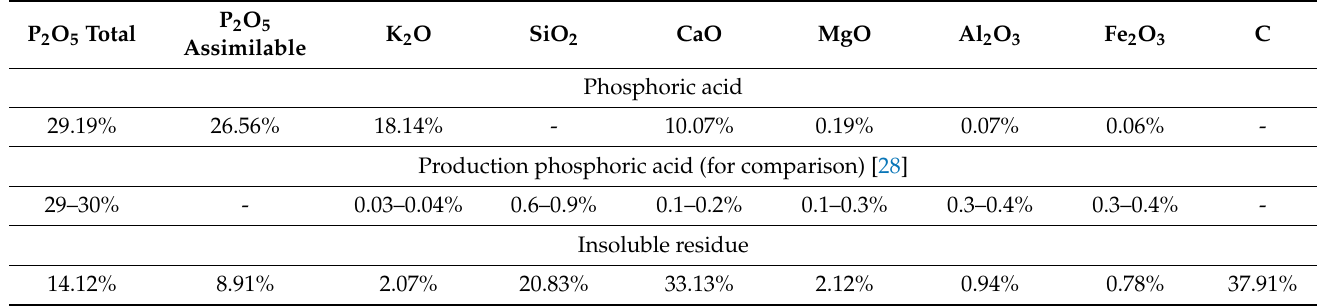
Table 5. Average chemical composition of phosphoric acid and insoluble